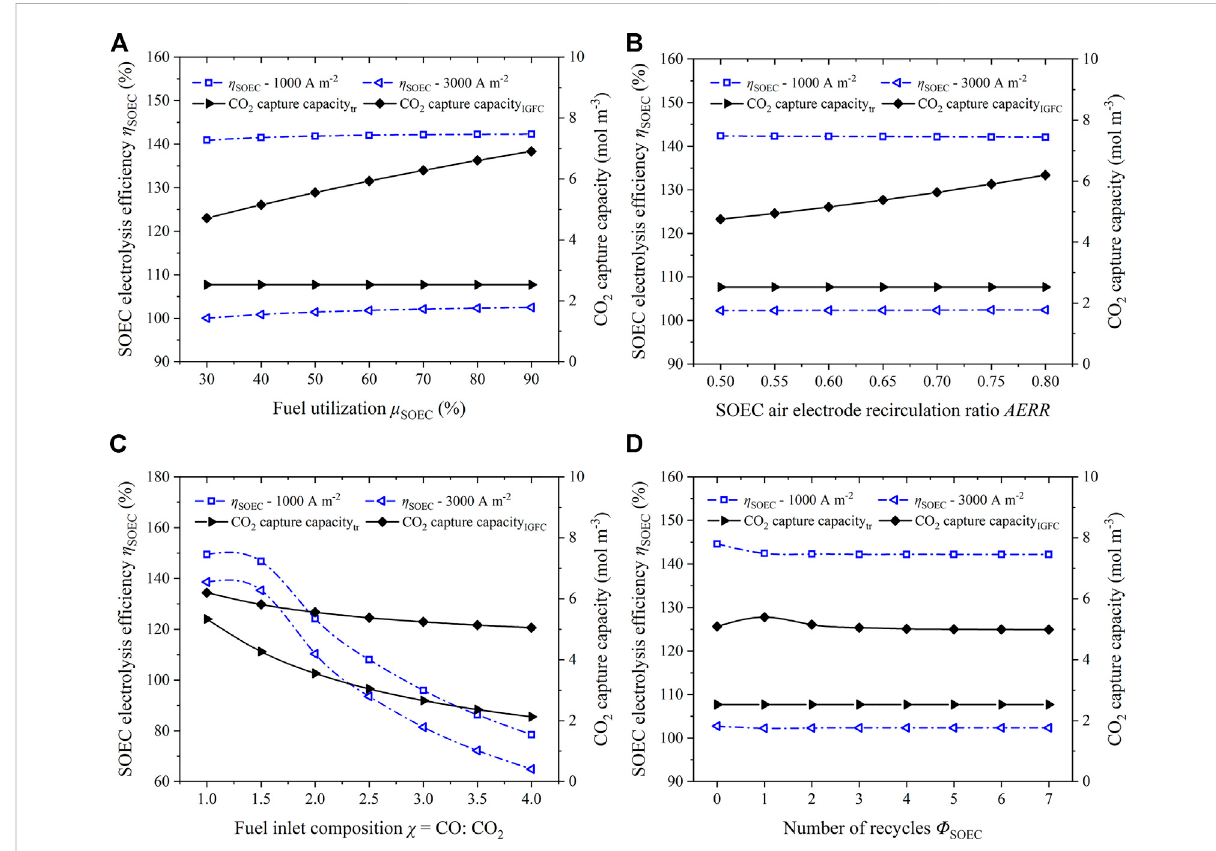
FIGURE 10 In fl uenceofmainparametersonCO 2 captureandelectrolysisef fi ciencyofSOEC: (A) Fuelutilization μ SOEC ; (B) SOECairelectroderecirculation ratio AERR ; (C) Fuel inlet composition χ (cid:2) CO : CO 2 ; (D) Number of recycles Φ SOEC